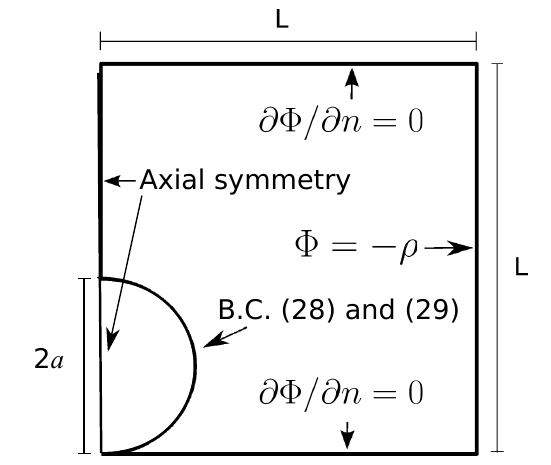
Figure A1. 2D axisymmetric domain for computing the electrical torque on a sphere resting on a plane. The domain dimensions are much larger than the sphere radius L (cid:29) a (not to scale in the figure).